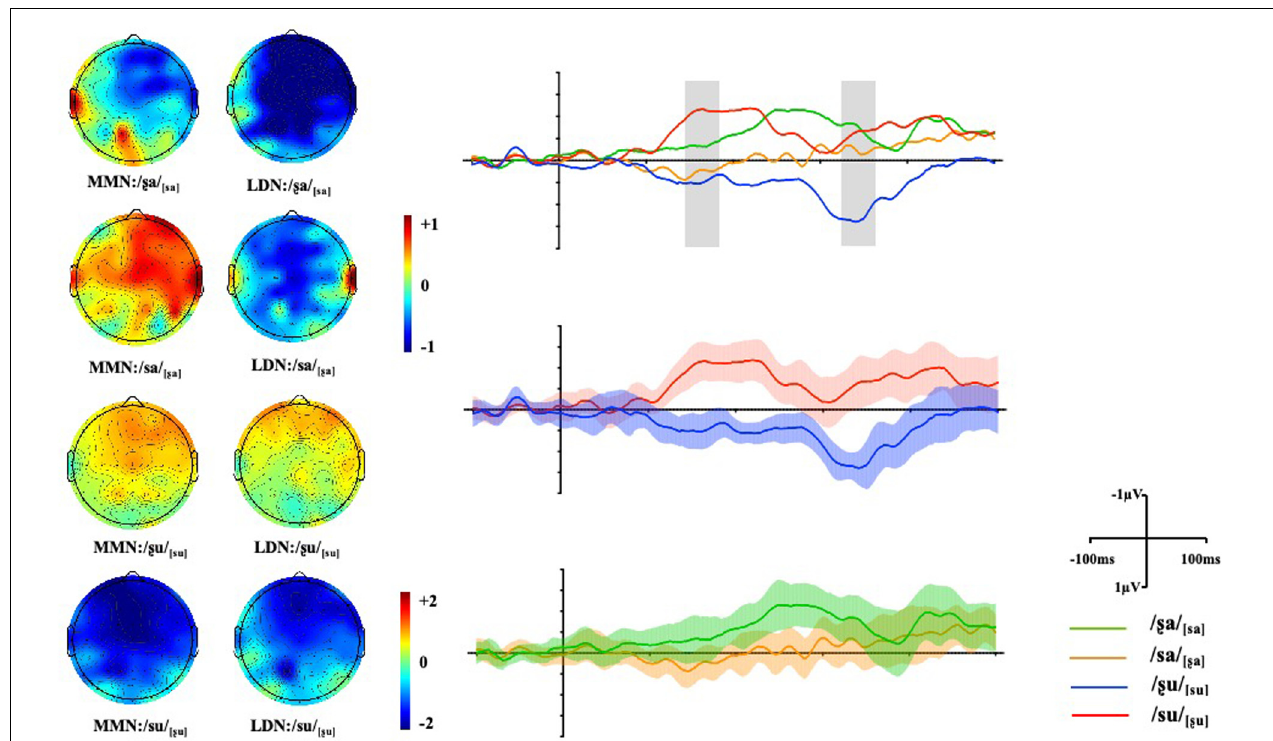
FIGURE 4 | Maps display the topographic distribution of the mean amplitude in both the MMN and LDN analysis windows from 140–180 ms and 320–360 ms respectively. Grand-average difference waveforms of all four conditions at Fz (see Supplementary Material for the waveforms at all selected electrodes). Shade areas show 95% confidence